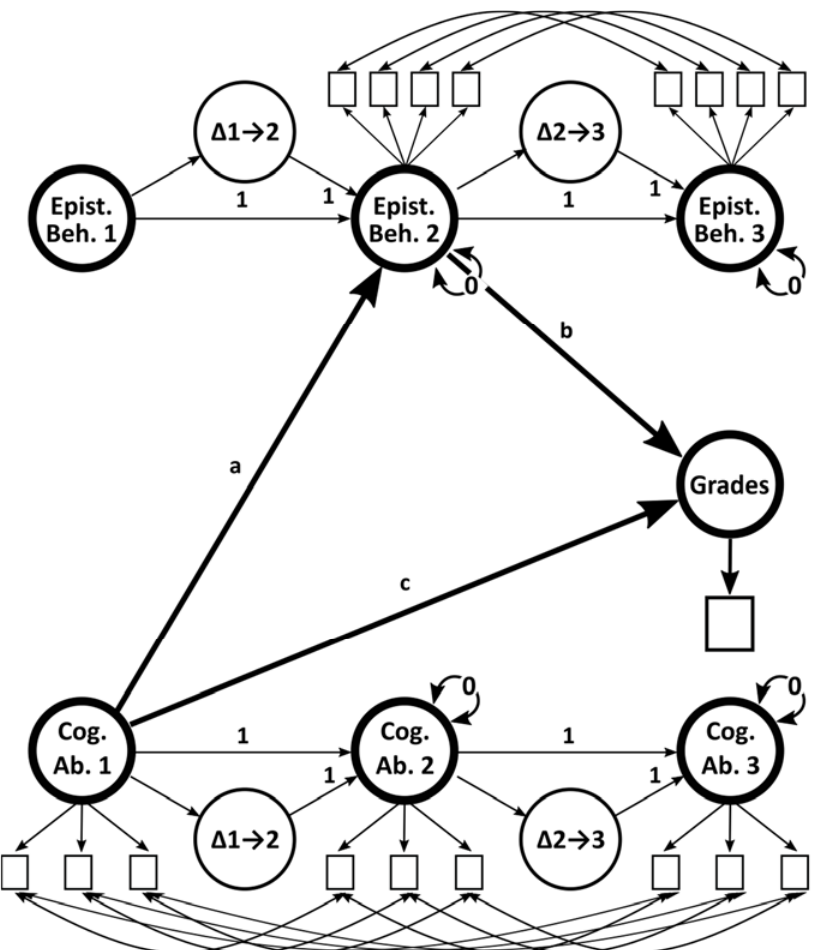
Figure 1. Schematic figure of the latent growth model with mediation effects. Epist. Beh.: epistemic behavior; Cog. Ab: cognitive ability. Epistemic behavior was not measured at time 1 and was included as a phantom variable. In a separate model, curiosity (instead of cognitive ability) was used as predictor.